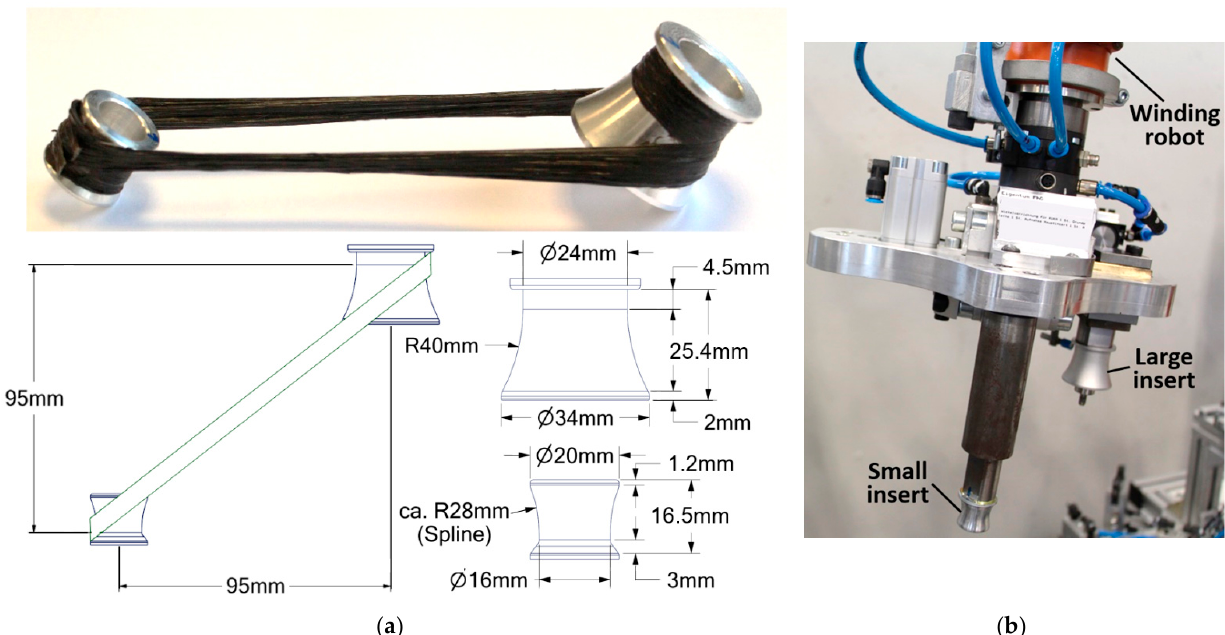
Figure 3. ( a ) Inclined loop specimen after [4] with dimensions; ( b ) Corresponding winding form.